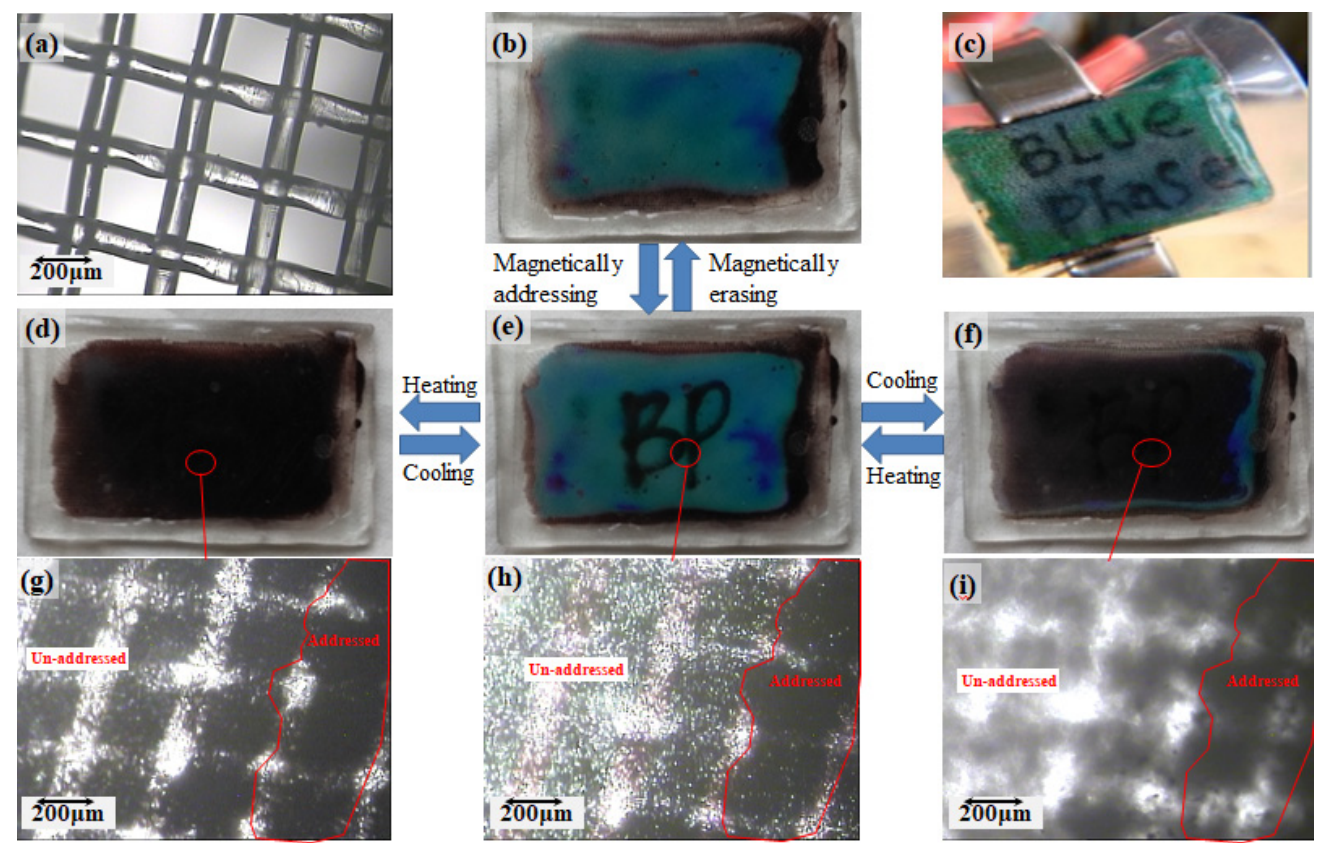
Figure 8. The “write-erase” process for magnetically driven BPLCDs. ( a ) Optical microscopy image of a nylon polymer network used in the LC composites; ( b ) photograph of LC cell with Fe 3 O 4 doped BPLC before magnetically addressed; ( c ) photograph of Fe 3 O 4 doped BPLC sandwiched between two flexible PET films; ( d – f ) photographs of the prepared cell containing Fe 3 O 4 doped BPLC in the nylon polymer network after being magnetically addressed in isotropic phase, BP phase and N* phase, respectively; ( g – i ) optical microscopy image of the prepared cell containing Fe 3 O 4 doped BPLC in the nylon polymer network after magnetically addressing in isotropic phase, BP phase and N* phase, respectively. [86]. Preparation and optical properties of Fe 3 O 4 nanoparticles-doped blue phase liquid crystal from He, Phys Chem Chem Phys, published by ROYAL SOCIETY OF CHEMISTRY. Photonic shape-memory polymers are advanced polymers that have a shape-memory effect accompanied by a color change; they can block the propagation of light under certain conditions [87–89]. Yang et al. reported a fabricated freestanding BP film of photonic shape- memory polymers achieving high optical reversibility for patterned reconfigurable BP films [90]. Such photonic films have excellent optical properties [91]. As shown in Figure 9, a blue “BP” pattern was written on the green BP film using a shape-memory programming process with specific pressure on the film, which could be erased by a shape-memory recovery process after the polymer film was heated. The pressure-driven handwritten film is simple to prepare and easy to eliminate, and is expected to be an alternative to traditional